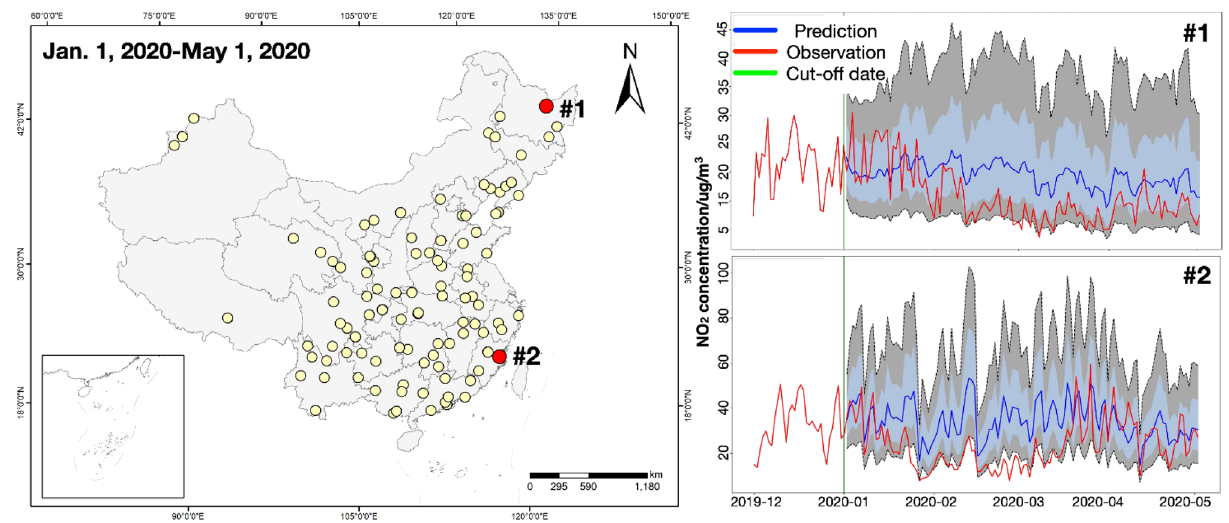
Figure 3. Predicted NO 2 concentrations of selected air stations using SARIMAX during Jan. 1st, 2020 to May 1st, 2020. Two air stations #1 and #2 were selected. Red lines indicate the observed NO 2 concentrations, blue lines indicate the predicted NO 2 concentrations, and green lines represent the cut-off date of NO 2 estimation. The blue and grey areas indicate the one and two standard deviation(s) of NO 2 predictions. The map is performed using ArcGIS Pro software (version 2.7, https:// www. esri. com/ en- us/ arcgis/ produ cts/ arcgis- pro/ overv iew).